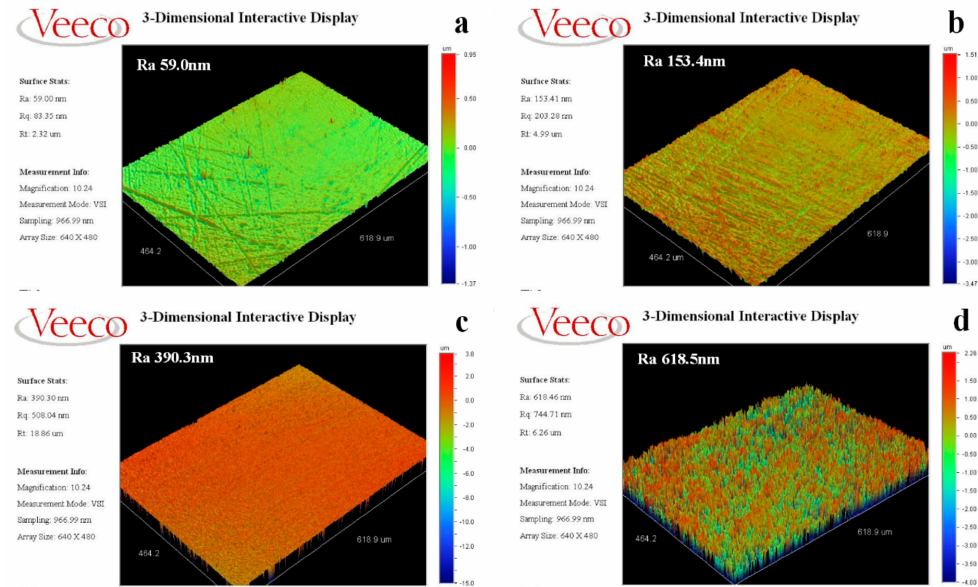
Figure 7. Surface roughness of the metal Ni films treated with different methods ( a ) untreated; ( b ) 5 vol % HCl for 10 min; ( c ) pulse reverse current; ( d ) anodic current density with 30 mA/cm 2 for 10